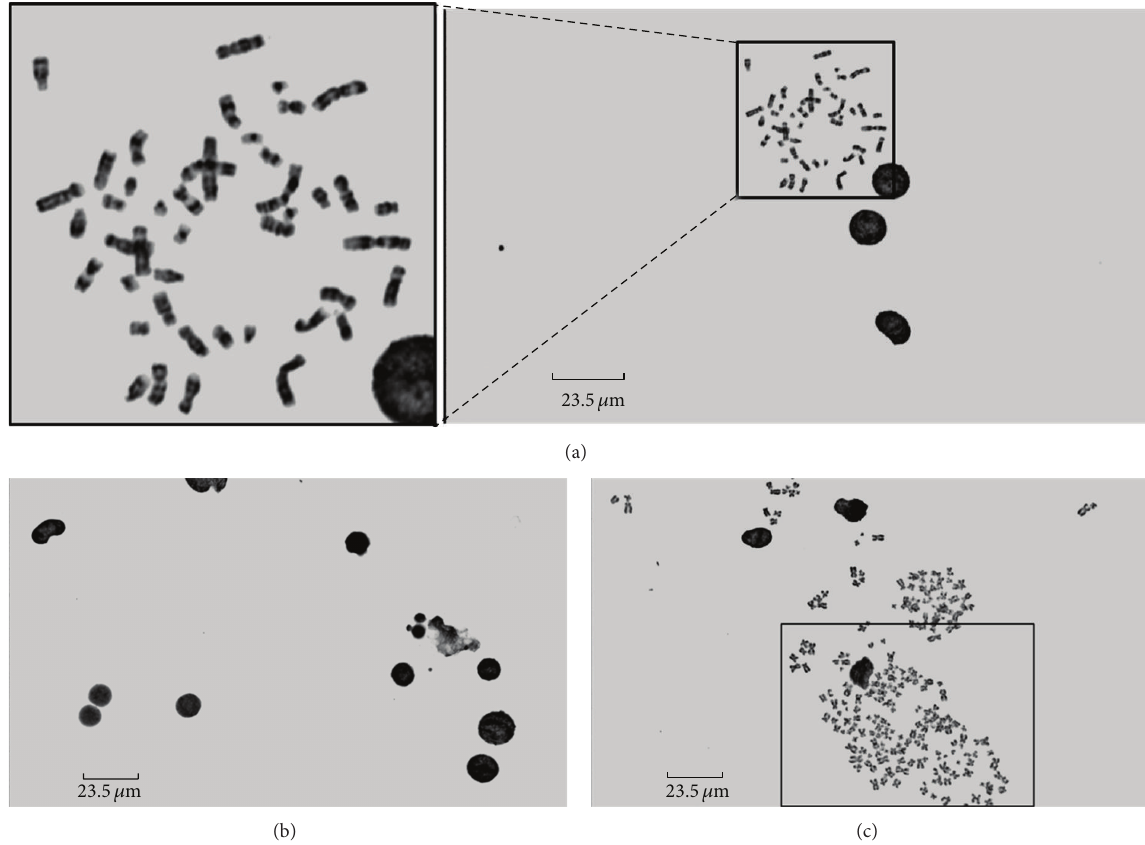
Figure 1: Examples of the microscopic images captured by the high throughput scanner. The cells were acquried under 100x objective lens and imaged by a TDI detector with a pixel size of 7 𝜇 m. Image (a) contains a clinically analyzable region of interest (ROI). Images (b) and (c) contain interphase cells and overlapped metaphase chromosomes, respectively, which are unanalyzable for the diagnosis.